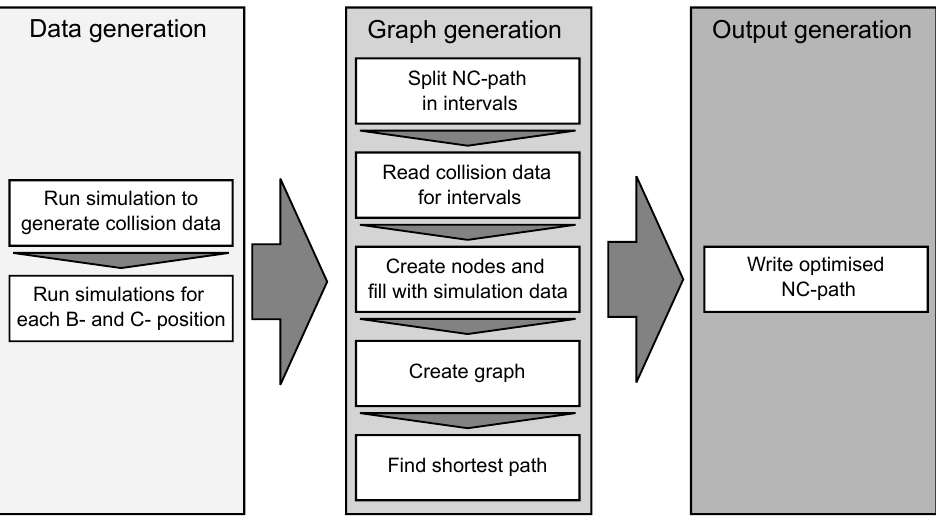
Figure 8. Principle of the optimisation